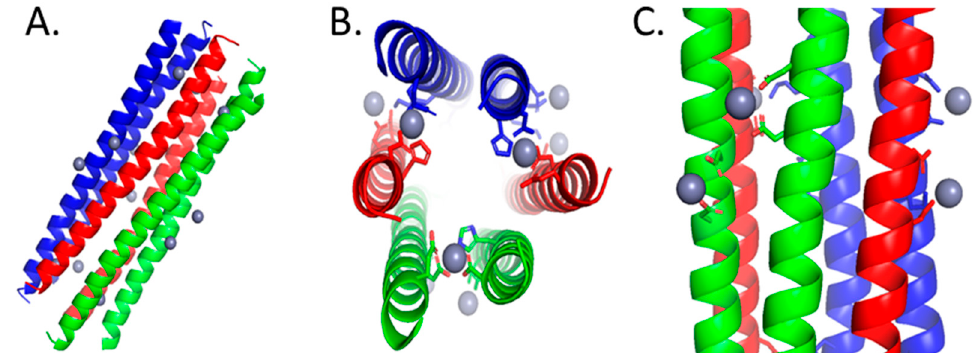
Figure 1. The color coordination signifies the paired peptide helices that are oriented in head-to-tail directions. Amino acids with prime labeling are associated with the peptide in the reverse direction. ( A ) Full-length structure of DCD-1L forming a trimer of Zn-bridged dimers. ( B ) Top-down view of the trimer of dimers highlighting the amino acids, Glu5, Glu9, His38 (cid:48) , and Asp42 (cid:48) , that coordinate to the inner sphere of Zn(II). ( C ) The trimer of dimers’ 3 ◦ structure is also stabilized by amino